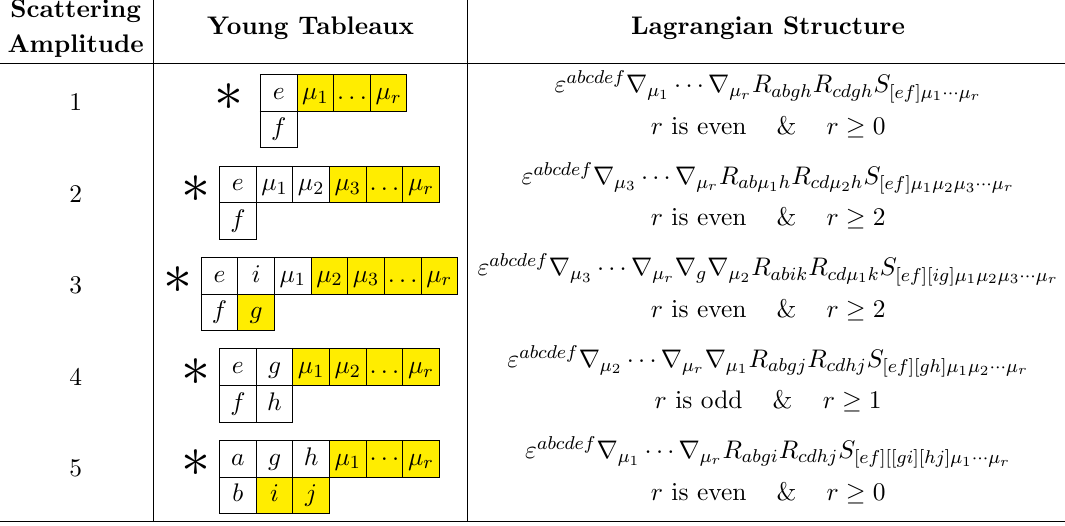
(cid:3) Table 8. Gravitons , D = 6. The meaning of the symbol was explained in the caption to table 2. to one three point structure when r is odd, and its dual leads to another (parity odd) three point structure when r is even. The doubling of structures is a re(cid:13)ection of the fact that the tableaux Y corresponds to 2 SO(4) irreps, namely the (3 ; 1) and the (3 ; (cid:0) 1) (3 ; 1) representations.The new parity odd structure is listed in row 3 of table